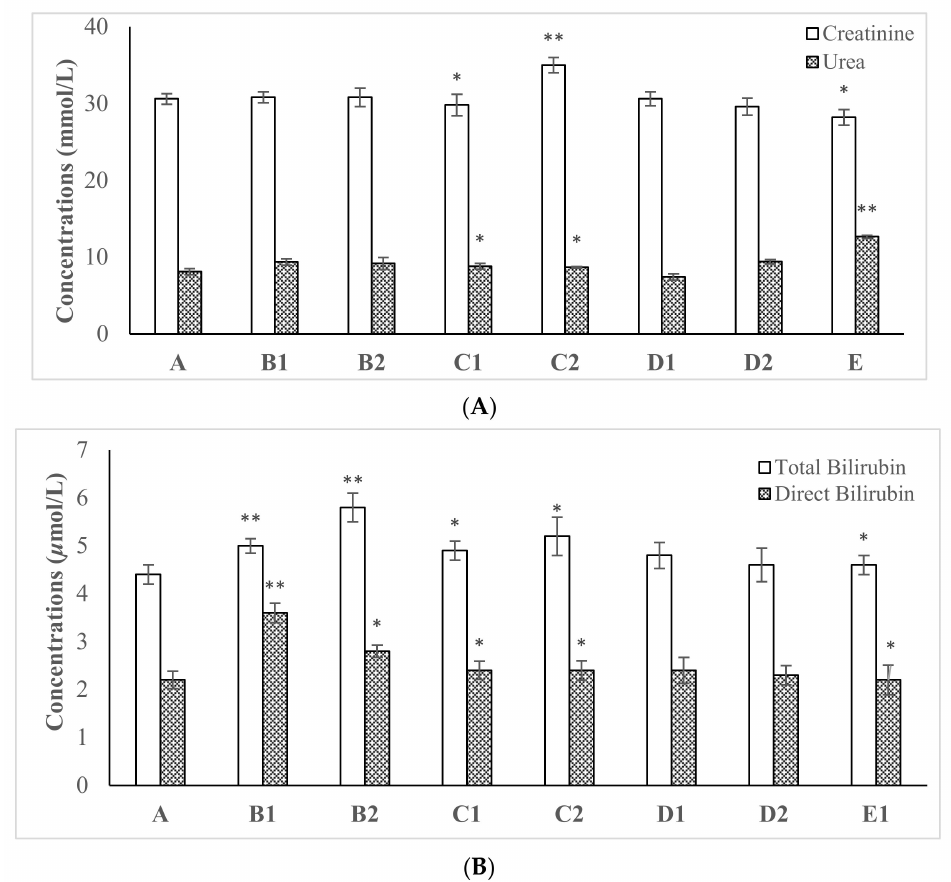
Figure 2. The effect of various concentrations of biosynthesized ZnO NPsAL on serum concentra- tions in rats ( A ) creatinine and urea ( B ) total bilirubin and direct bilirubin. Data are presented as mean ± SEM of at n ≥ 5 least replicate experiments and analyzed using one-way ANOVA followed by Newman–Keuls post hoc analysis. (*) p < 0.05; (**) p < 0.01; Abbreviations: A, Control; B1, 0.01M ZnO NPsAL (80 mg kg − 1 ); B2, 0.01 M ZnO NPsAL (40 mg kg − 1 ); C1, 0.05 M ZnO NPsAL (80 mg kg − 1 ); C2, 0.05 M ZnO NPsAL (40 mg kg − 1 ); D1, 0.1 M ZnO NPsAL (80 mg kg − 1 ); D2, 0.1 M ZnO NPsAL (40 mg kg − 1 ); E, Zinc nitrate solution (80/40 mg kg − 1 ). The effect of various concentrations of synthesized ZnO NPsAL on rat serum protein, albumin, and globulin (Figure 3; n ≥ 5) following 28 days oral exposure was not significant in all concentrations and zinc nitrate solution except 0.05 M ZnO NPsAL when compared with the control ( p < 0.05; n ≥ 5; Figure 3). In contrast, the serum level of total protein and globulin was elevated with all the concentrations compared with the control group (Figure 3; n ≥